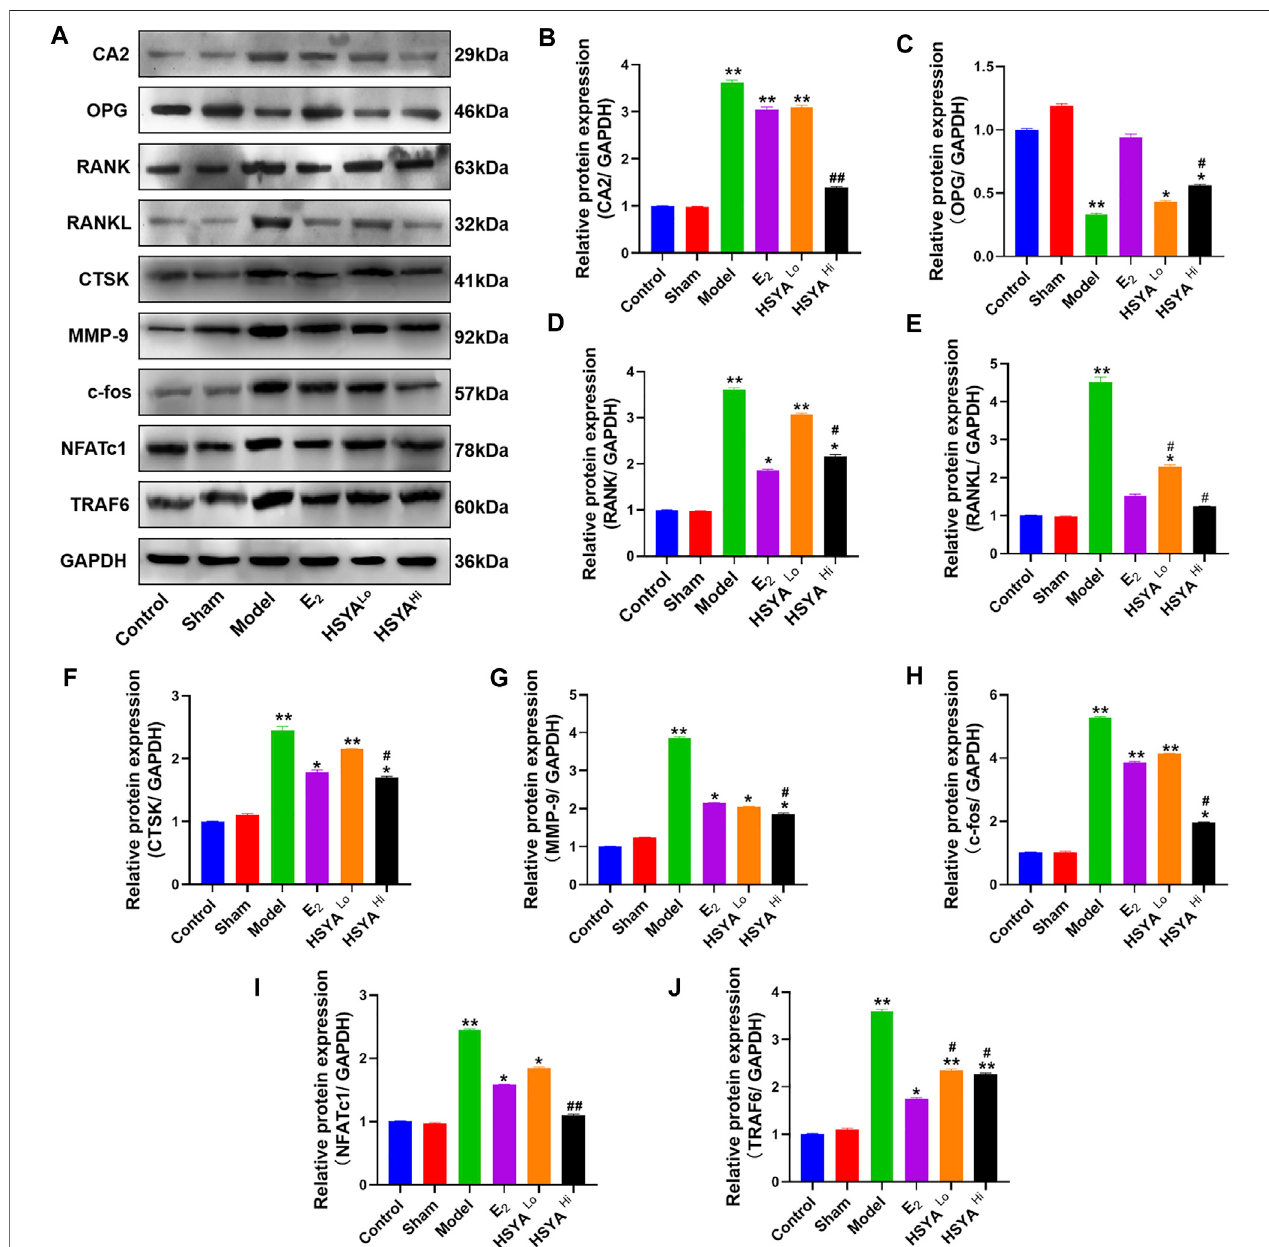
FIGURE 7 | Regulation of CA2 and osteoblast differentiation-related proteins by HSYA. (A) The relative expression levels of CA2, OPG, RANK, RANKL, CTSK, MMP-9, c-fos, NFATc1, and TRAF6 proteins were detected by western blotting. (B – J) The gray values of CA2, OPG, RANK, RANKL, CTSK, MMP-9, C-FOS, NFATc1, and TRAF6 proteins were quanti fi ed by ImageJ software. “ ** ” indicates p < 0.01, “ * ” indicates p < 0.05, and the difference was statistically signi fi cant when compared withthecontrolgroup.Statisticalsigni fi cance. “ # ” indicates p < 0.05,andthedifference wasstatistically signi fi cantintheHSYAtreatmentgroupcompared withthe model